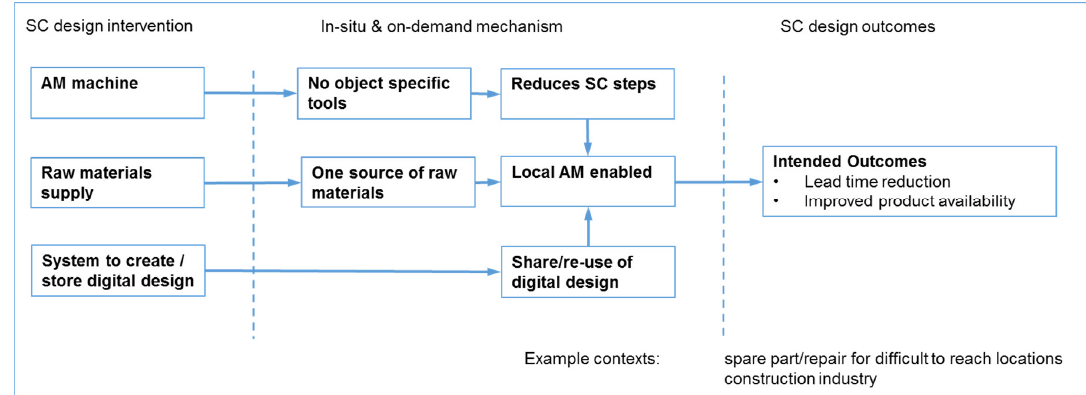
Figure 3. In-situ & on-demand mechanism.